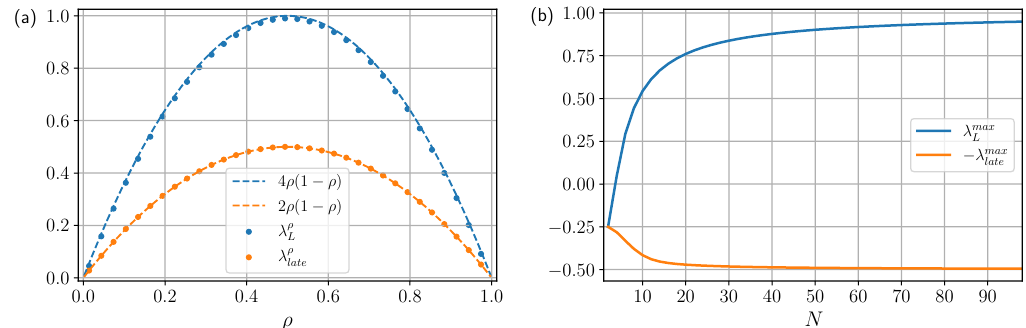
and the late-time exponent λ ρ vs ρ for L late and late-time exponent corresponding to the L ( t ) , χ † ) . The exponents of i j